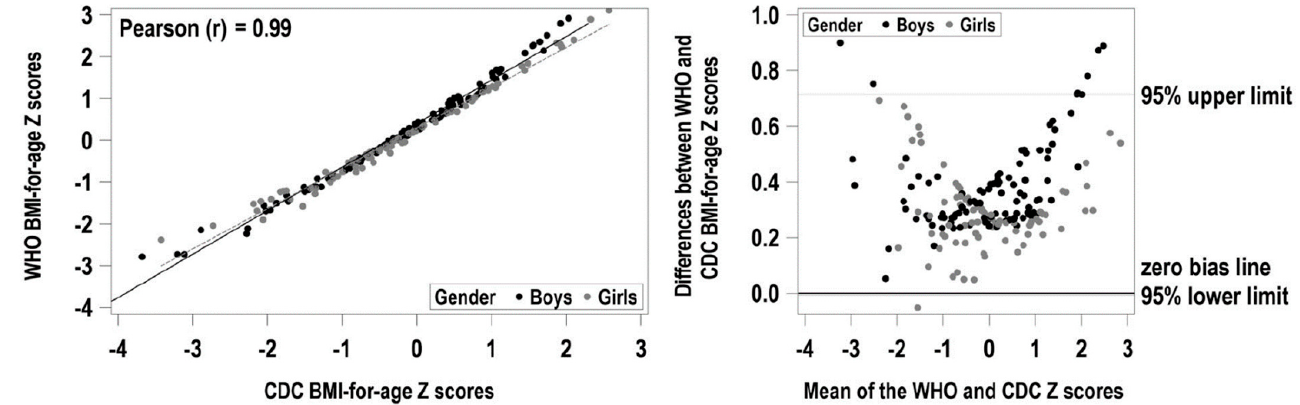
Figure 1. Relationship and agreement between World Health Organization (WHO) and Centers for Disease Control (CDC) body mass index z-scores. ( a ) Body mass index z-scores calculated using CDC norms. ( b ) Body mass index z-scores calculated using the WHO